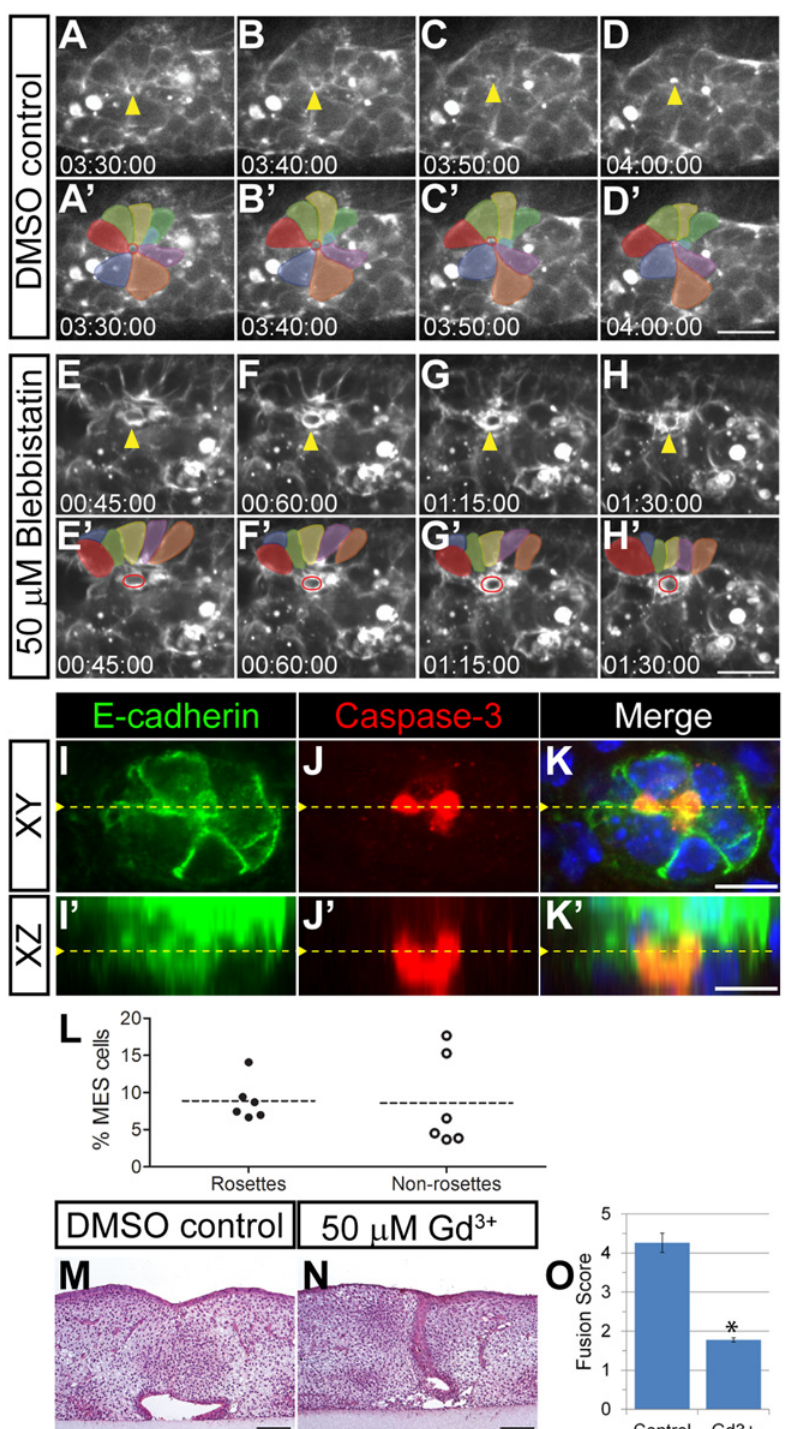
Fig 6. Multi-cellular rosette formation and cell extrusion during secondary palatal fusion. (A – D, A ’– D ’ ) An example of rosette formation (colored) and cell extrusion in high magnification confocal live imaging of Lifeact-mRFPruby palatal explants. The extruding cell is marked by a yellow arrowhead (A – D) and red circles (A ’– D ’ ). Scale bar, 10 μ m. (E – H, E ’– H ’ ) Disrupted rosette formation is observed upon inhibition of NMII with blebbistatin. The few extrusion-like events that were observed in blebbistatin-treated palate explant